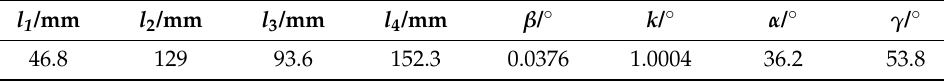
Table 2. Optimization results of the four-bar mechanism.